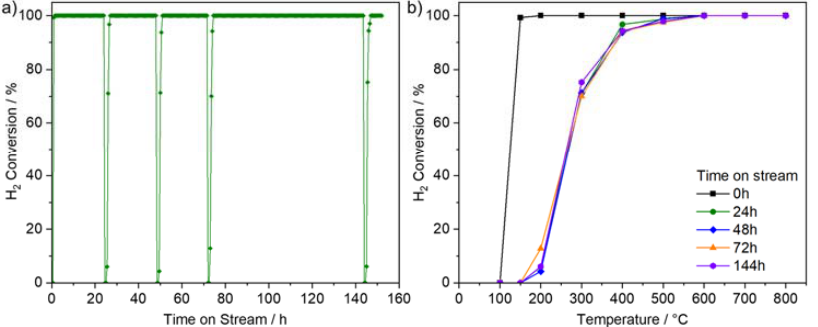
Figure 8. ( a ) Hydrogen conversion over time on stream with frequent cold start experiments and ( b ) hydrogen conversion over temperature for the corresponding cold start experiments after different times, catalyst 5% Pt/Al 2 O 3 , T Reactor = 800 °C (cold starts from 100 to 800 °C), WHSV = 600 L/g h.